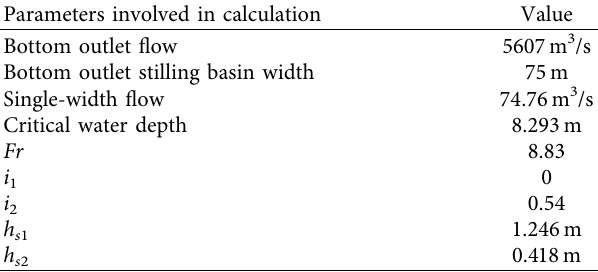
Table 4: The main calculation parameters of critical sedimentation height of bottom outlet stilling basin.